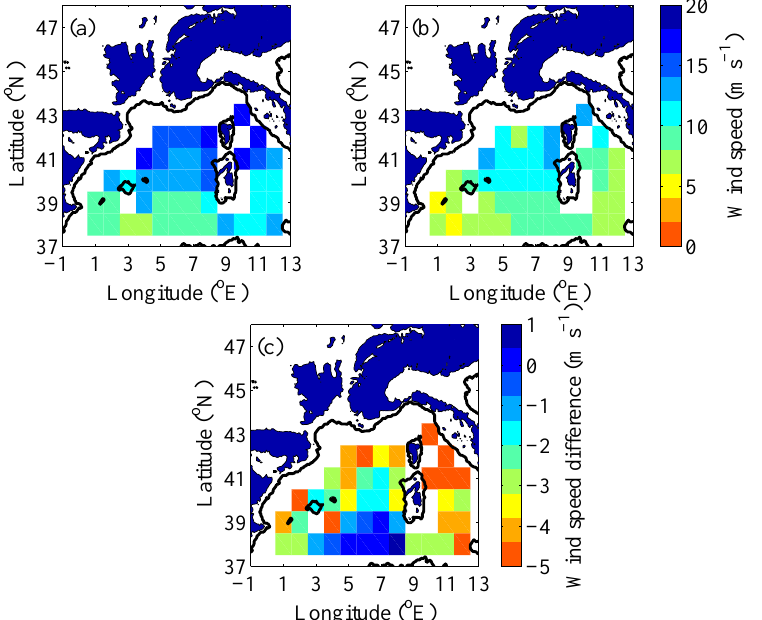
Fig. 5. (a), (b) and (c) are the daily mean values of the wind speeds measured on March 24, 1998 by the AMI-Wind/ERS satellite over sea surface, simulated by MM5 (domain 3) and the difference between the measured and simulated wind speeds, respectively. (a) and (b) are with the same color scale.